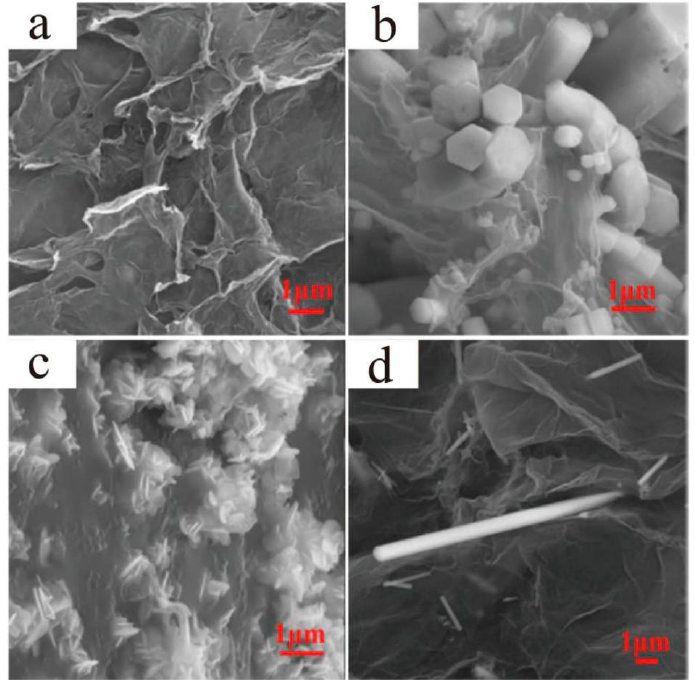
Figure 13. Micromorphology of synthesized nanoparticles: ( a ) graphene, ( b ) prism-like ZnO@graphene, ( c ) sheet-like ZnO@graphene, ( d ) rod-like ZnO@graphene [86]. Reproduced with permission from [Baijing Ren et al.], [Tribology International]; published by [Elsevier], 2020.